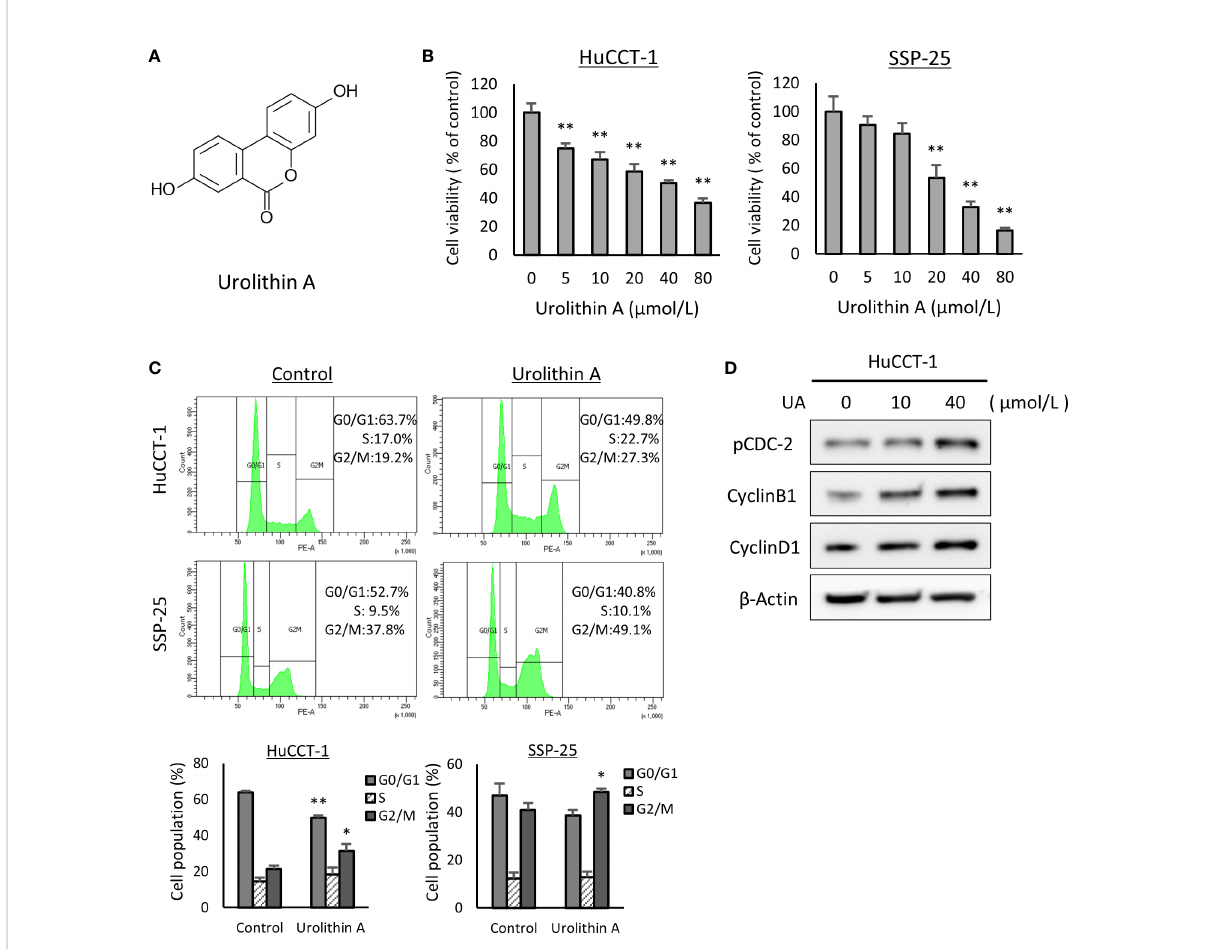
FIGURE 1 UA treatment inhibits cell proliferation and induces G2/M phase cell cycle arrest in cholangiocarcinoma cell lines. (A) Chemical structures of UA. (B) HuCCT-1 and SSP-25 cells were treated with UA at 0 – 80 m mol/L for 48 h Cell viability was measured using the Cell Counting Kit-8 assay. Data represent the means of three independent experiments. Bars, standard deviation; **P < 0.01. (C) HuCCT-1 and SSP-25 cells were treated with 0 or 40 m mol/L UA for 48 h Cell cycles were determined using fl ow cytometry. Data represent the means of three independent experiments. Bars, standard deviation; *P < 0.05; **P < 0.01. (D) HuCCT-1 were treated with 0, 10, or 40 m mol/L UA for 48 h Expression of cell cycle regulators was analyzed by Western blotting for phospho (p)-cdc2 (Try15), cyclin B1, and Cyclin D1. b -actin was used as